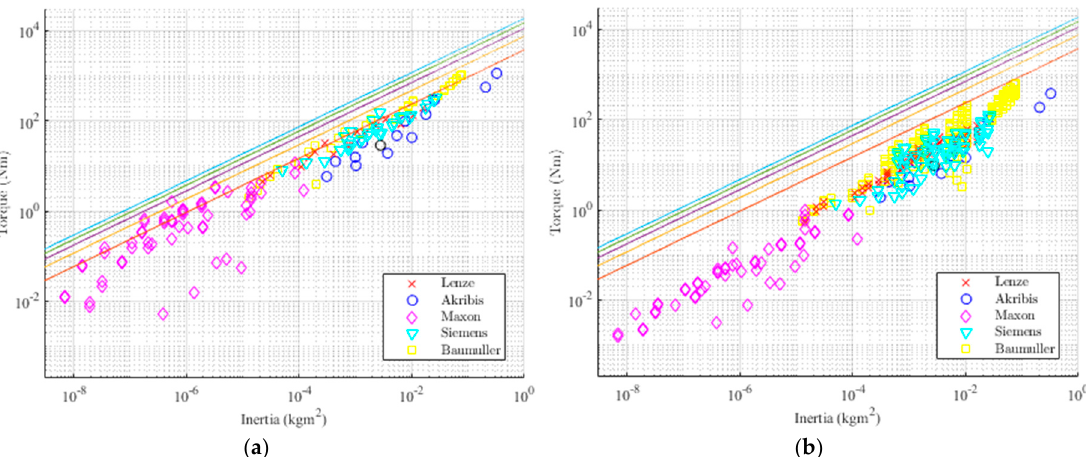
Figure 14. Benchmarking torque density of magnetic springs (1D scaling model) with pole pair numbers N pp = 1–5 vs. off-the-shelf highly dynamic PMSM ( a ) peak torque vs. inertia and ( b ) nominal torque vs. inertia.